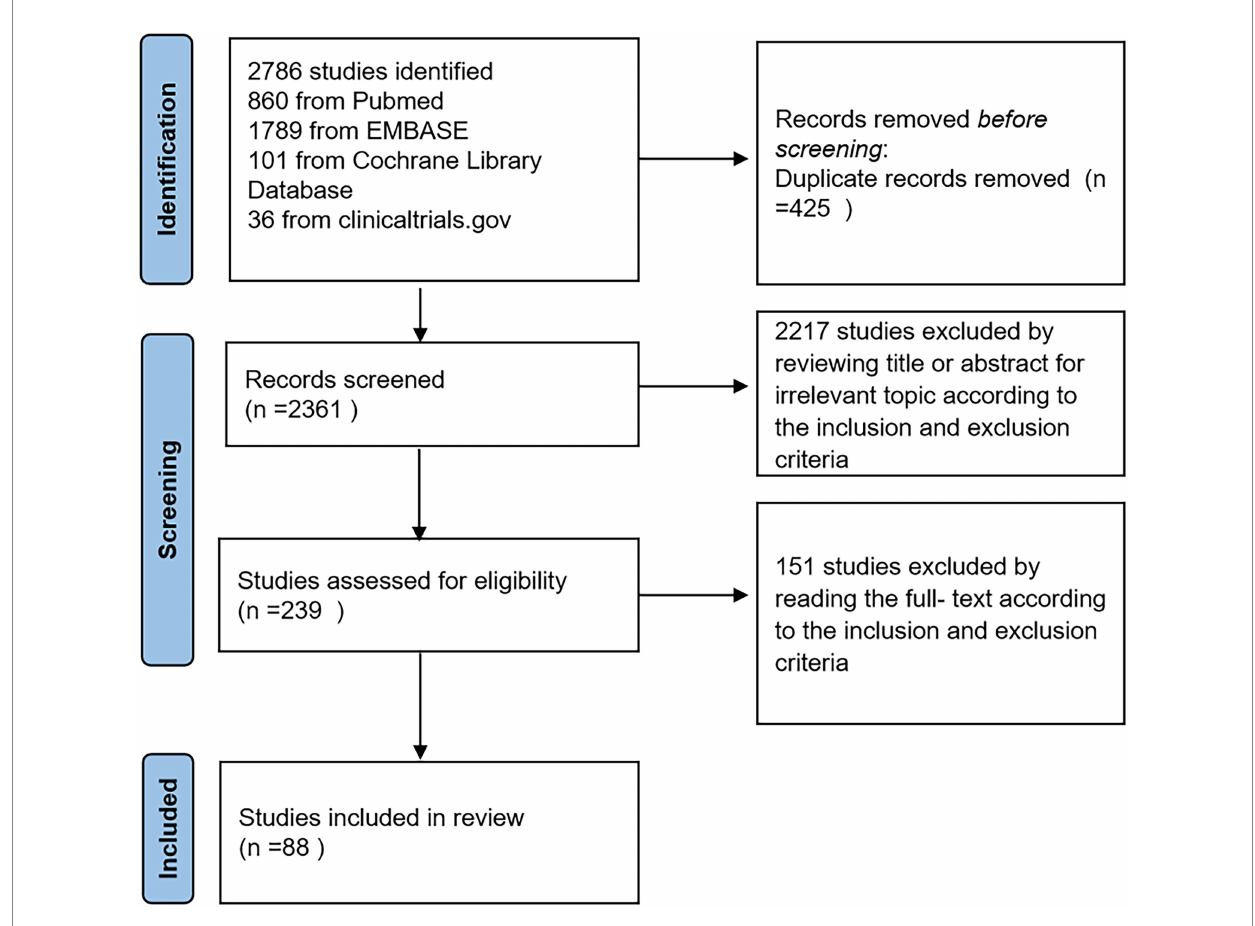
FIGURE 1 A flow diagram of the article screening